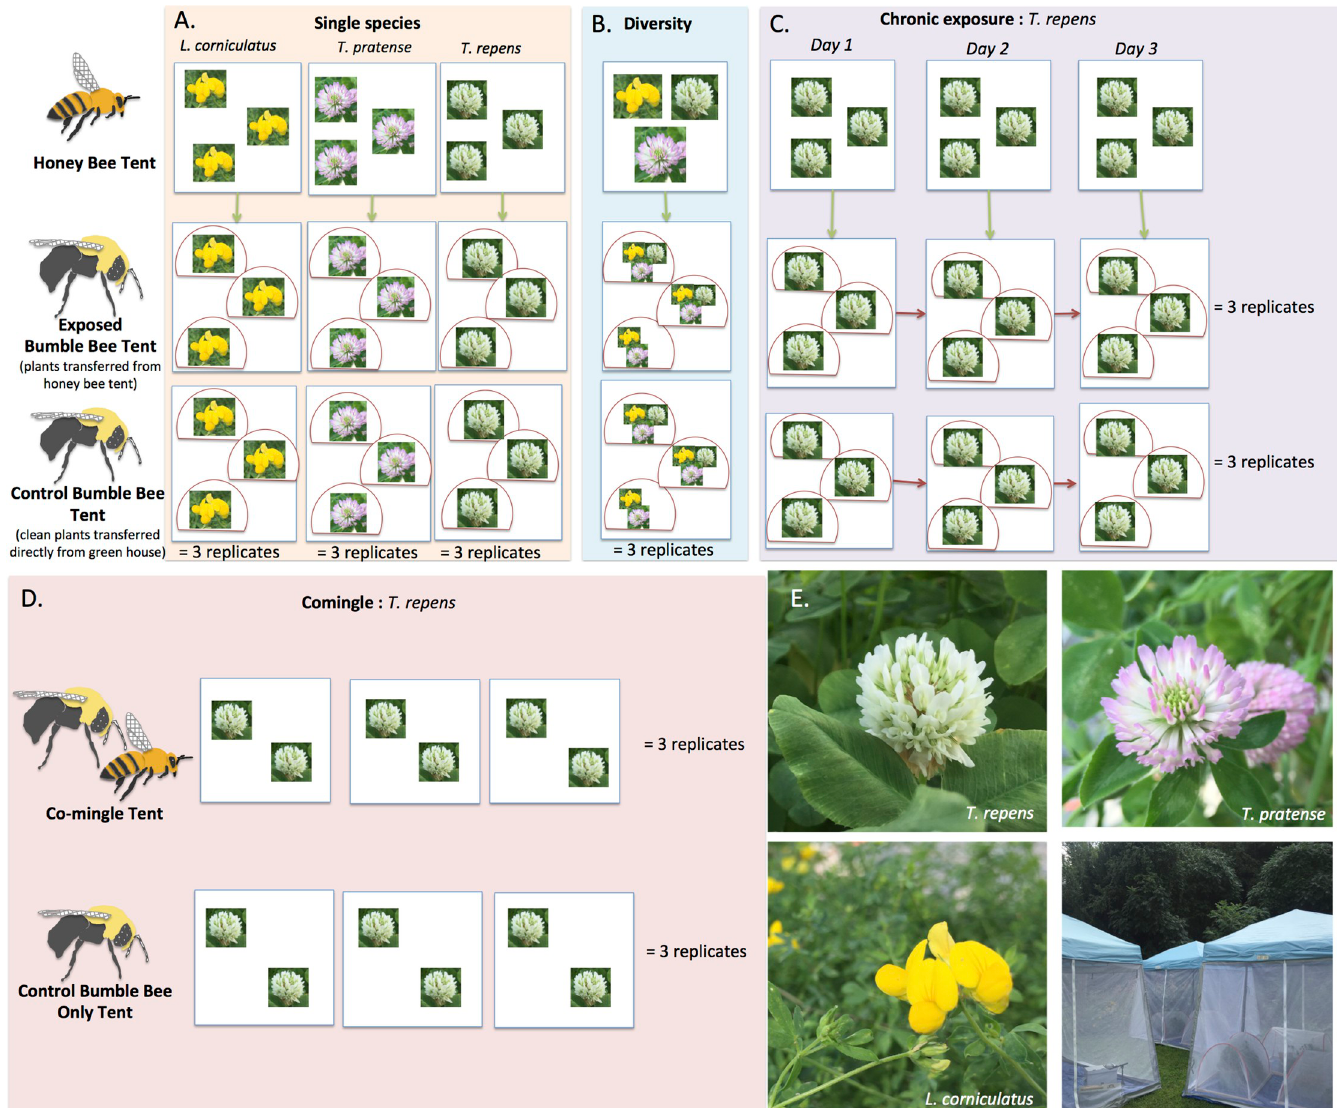
Fig 1. Schematic of experimental designs. In a series of four experiments, we examined virus deposition on flowers by honey bees and/or virus transmission between honey bees and bumble bees. To examine the effect of plant species and/or plant diversity, flowering plant species were provided to foraging bees as either single plant species (A) or in diverse arrays consisting of all three species (B). To test whether chronic exposure to contaminated flowers is necessary for virus transmission, bumble bee microcolonies were exposed three times to honey bee-visited flowers over the course of three days (C). To test if direct contact or comingling is necessary for viral transmission, honey bees and bumble bees were allowed to forage together in tent enclosures (D). Blue boxes in the schematic represent tent enclosures assigned as the honey bee tent (where infected honey bees were allowed to forage on flowers), the exposed bumble bee tent (where plants exposed to honey bees were transported into three hoop houses to be foraged on by bumble bee microcolonies), and the control bumble bee tent (where bumble bee microcolonies foraged on ‘clean’ plants brought directly from the greenhouse). Red semi-circles represent hoop houses within bumble bee tents, each containing a single bumble bee microcolony. Green arrows represent the movement of plants from the honey bee tent to the exposed bumble bee tent after a 15 hour nectar regeneration period. In the chronic experiment, the same three bumble bee colonies were used on each of three days (depicted by red arrows connecting the hoop house through time). Three plant species were used throughout the series of experiments: Trifolium repens , T . pratense , and Lotus corniculatus . Photos of inflorescences and tent enclosures (with hoop houses) are provided for visualization (E).